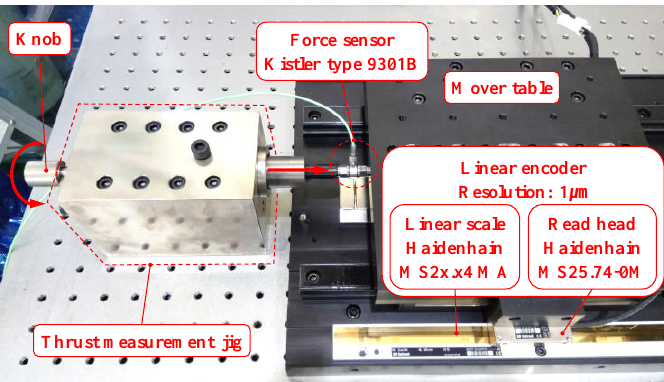
Figure 11. Prototype: ( a ) mover; ( b ) stator.